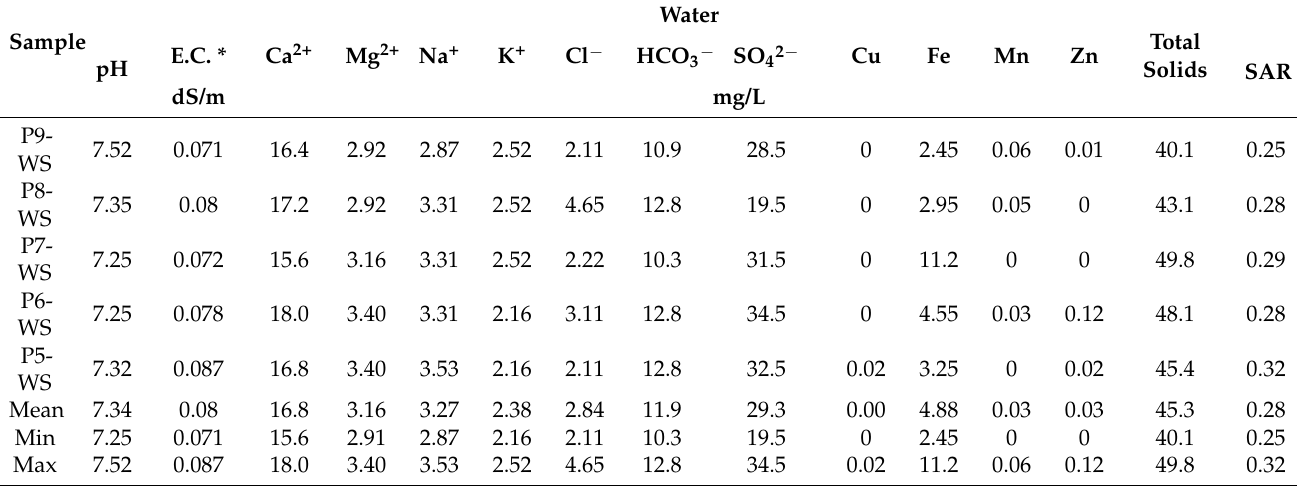
Table 6. Main chemical features of water samples of Para í ba do Sul River.